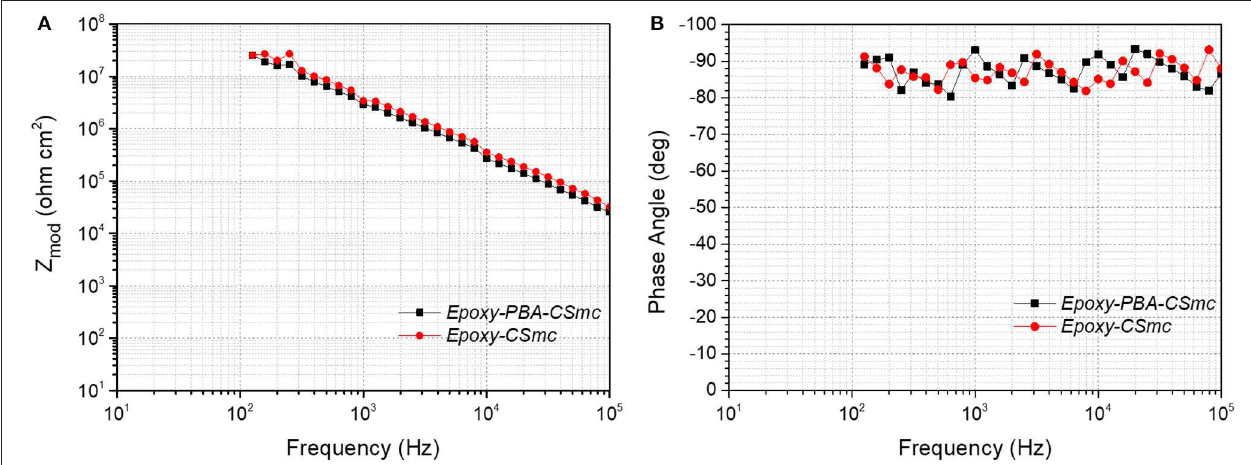
FIGURE 6 | EIS Bode diagrams of intact Epoxy-PBA-CSmc and Epoxy-CSmc coatings after exposure to artificial sea water (ASTM D 1141-98): (A) impedance modulus versus frequency and (B) phase angle versus frequency.